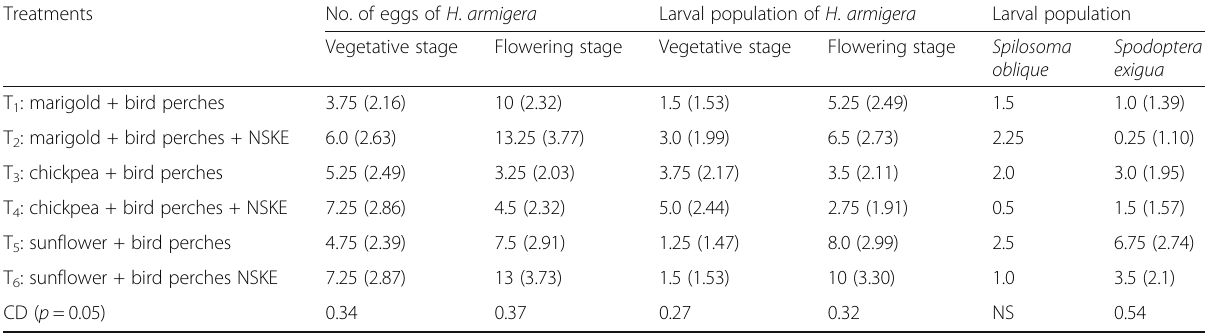
Table 3 Per plant egg and larval counts of H . armigera and other lepidopteran larvae on trap crop (per plant) in relation to berseem growth stages Treatments No. of eggs of H .